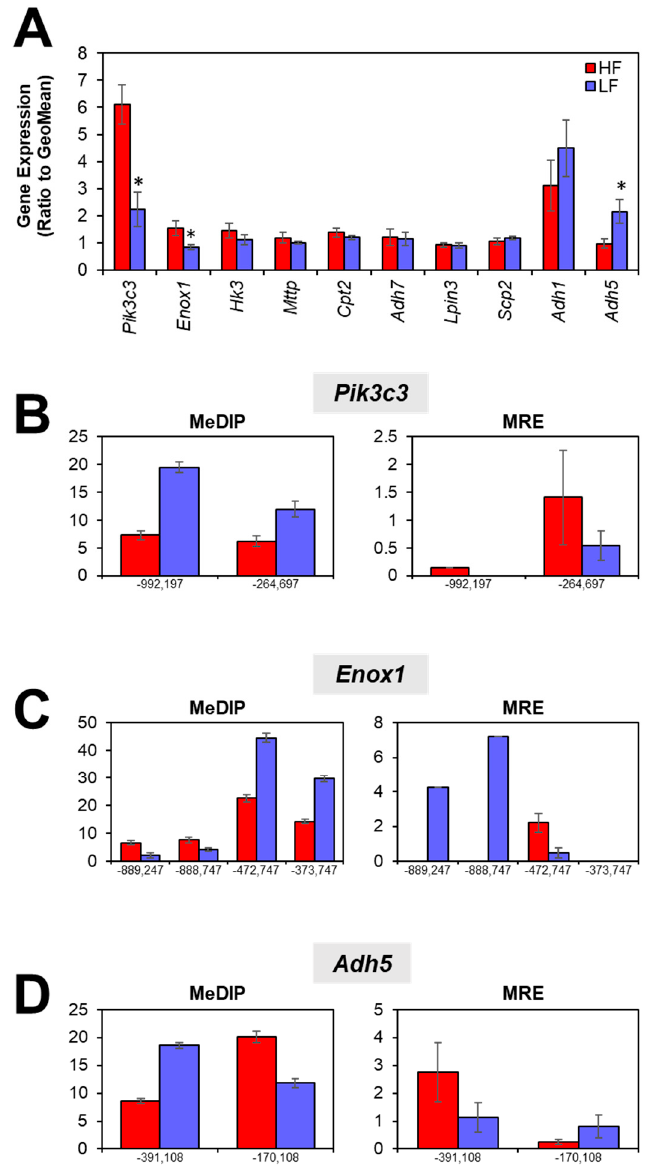
Figure 7. Expression of metabolic genes associated with intergenic DMRs. ( A ) Three genes were differentially expressed, including Pik3c3 , Enox1 , and Adh5 . DMRs within 1 mb upstream and downstream of the gene body are reported for ( B ) Pik3c3 , ( C ) Enox1 , and ( D ) Adh5 . MeDIP-seq and MRE-seq values are presented as average reads ± SEM.